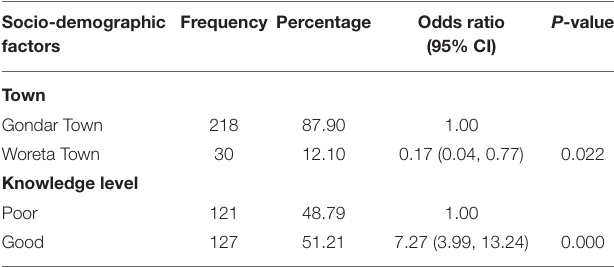
TABLE 9 | The final fitted model for the association of between sociodemographic factors and practice level of the respondents against epizootic